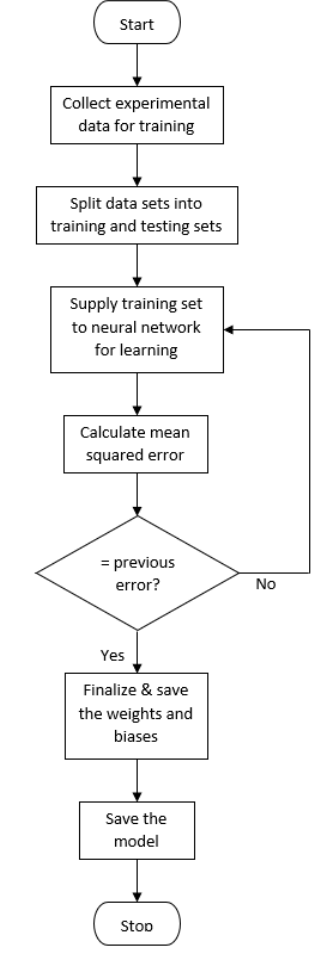
Figure 5. Flowchart overview of the modelling